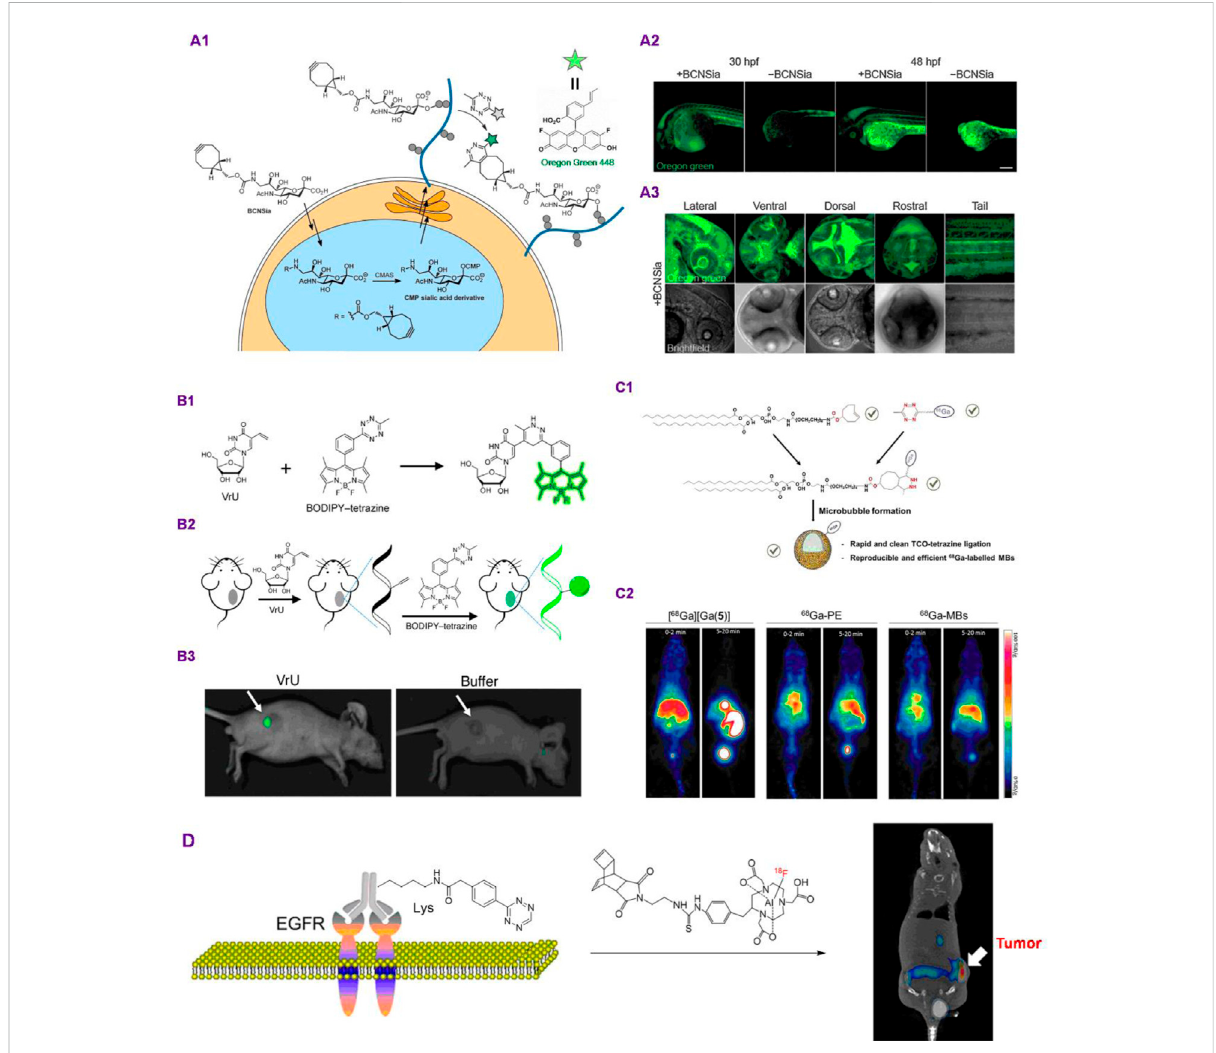
FIGURE 2 Applications of TBC for animal in vivo imaging. (A) Glycan-TBC for in vivo imaging. (A1) : Metabolic route for functionalization of BCNSia into cell-surface glycan analogs and its functionalization with tetrazine reporter; (A2) : projection images of 30 or 48 hpf embryos deal with BCNSia or vehicle; A3: projection images (20×) of 48 hpf embryos from a number of viewpoints (Copyright 2015 Wiley-VCH). (B) TBC for nucleic acids in vivo imaging. (B1 – B2) : Schematic of Diels − Alder reaction between BODIPY − tetrazine with VrU acted as the light-up reporter method; (B3) : in vivo imagination of mice from buffer along with VrU groups, tumor tissues are labelled with arrows (Copyright 2019 American Chemical Society). (C) Lipid-TBC for in vivo imaging. (C1) : Development of bioorthogonal building blocks for “ click ” ligation for the preparation of 68 Ga-labelled MBs. (C2) : PET imagination of Balb/c nude mice after intravenous injection of 68 Ga (left), 68 Ga-labelled PE (middle) and, 68 Ga-labelled MBs (right) at different time intervals (Copyright 2019 Royal Society of Chemistry). (D) Pretargeted immuno-PET rely on TPC for imaging EGFR positive colorectal cancer (Copyright 2018 American Chemical